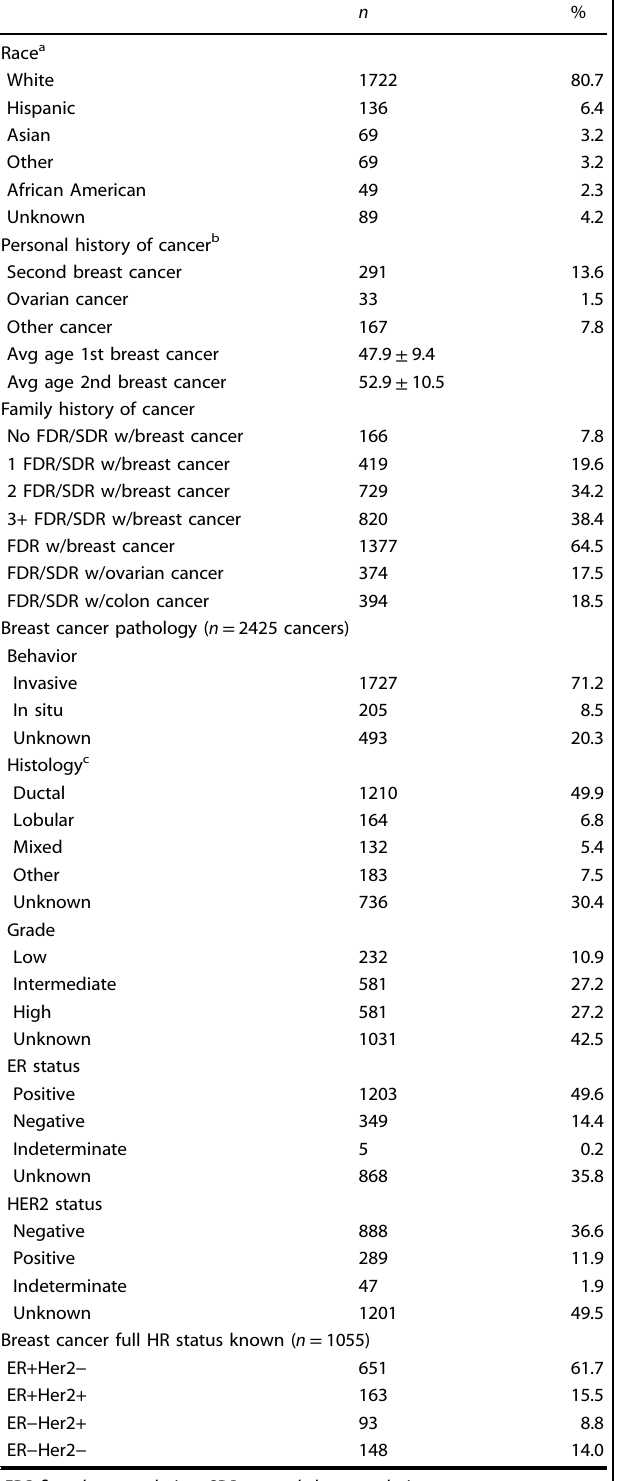
Table 1. Phenotypic and pathological features of 2134 women with familial breast